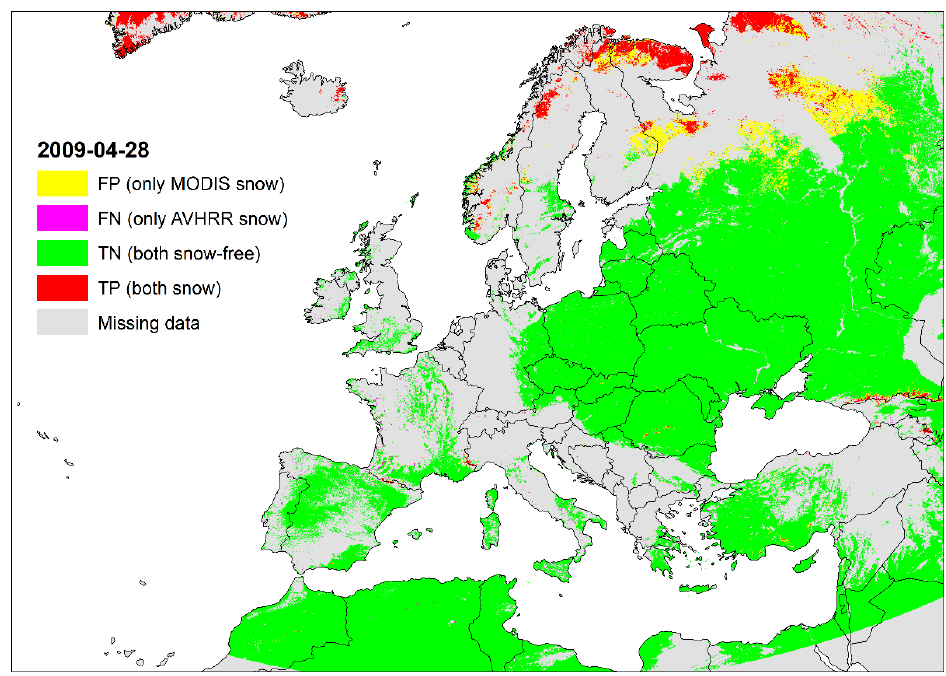
Figure 11. Daily composite of the classification accuracy for 28 April 2009—the date with the best matches between MODIS and AVHRR in terms of TNR (95.67%) and ACC (95.58%). PPV also has its maximum in spring: on 11 April 2009. The snow cover is only under- estimated in small areas of Scandinavia, the remaining areas are mapped well (Figure 12). is related to a better recognition of the snow surface and is independent of an increase in the “snow-free” area.